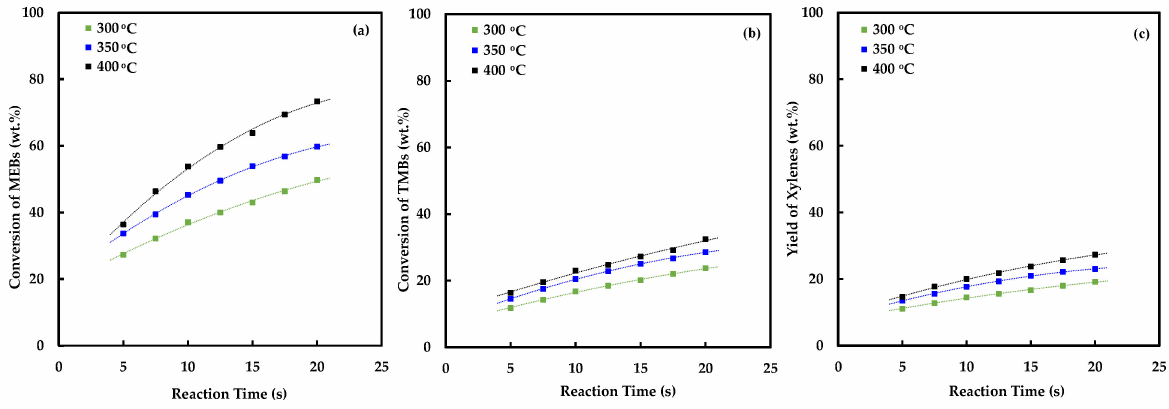
Figure 1. Conversion of MEBs ( a ), TMBs ( b ) and the yield of xylenes ( c ) as a function of reaction time and temperature.